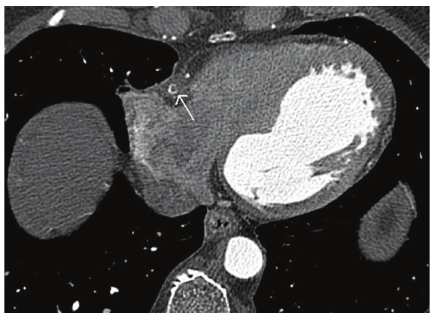
Figure 1: Nonenhancing fluid collection (arrow) around the RCA stent.